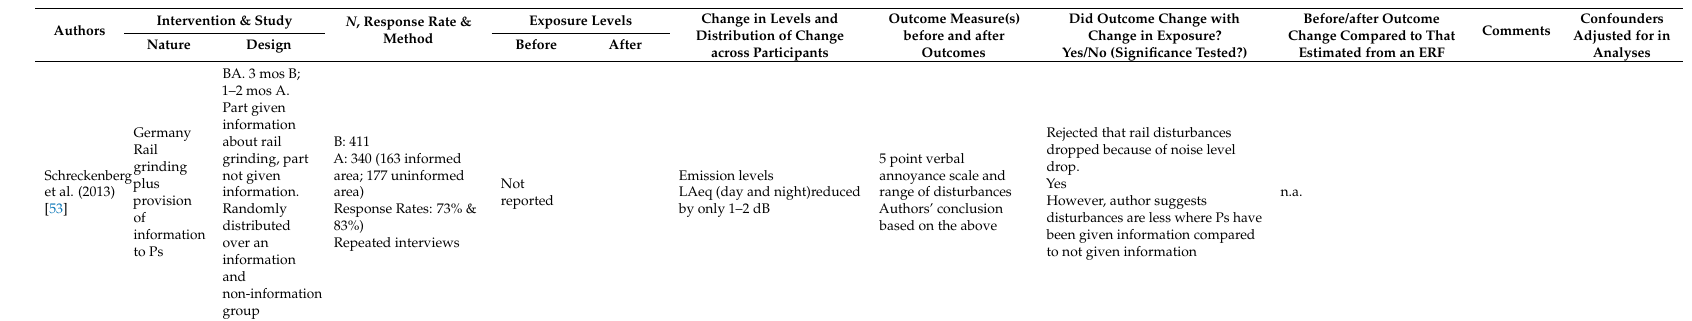
Table 18. Education/Communication Intervention (Type